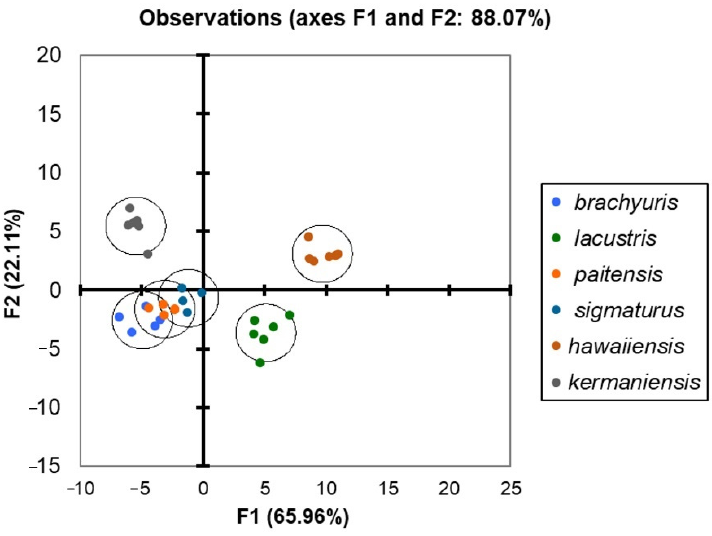
Figure 4. Hierarchical cluster analysis for six species of Mylonchulus .